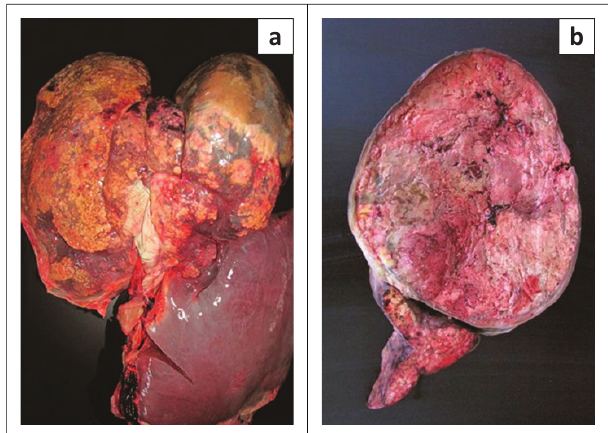
FIGURE 3: Histological sections of the liver from a 3-year-old Thoroughbred colt that suffered from fatigue fractures (depicted in Figure 1) as well as consistent erythrocytosis. (a) Multiple tumour nodules compressing adjacent hepatic parenchyma ( * ) (HE × 4). (b) Tumour cells are round, relatively homogeneous and form small nests supported by fine stroma (HE ×